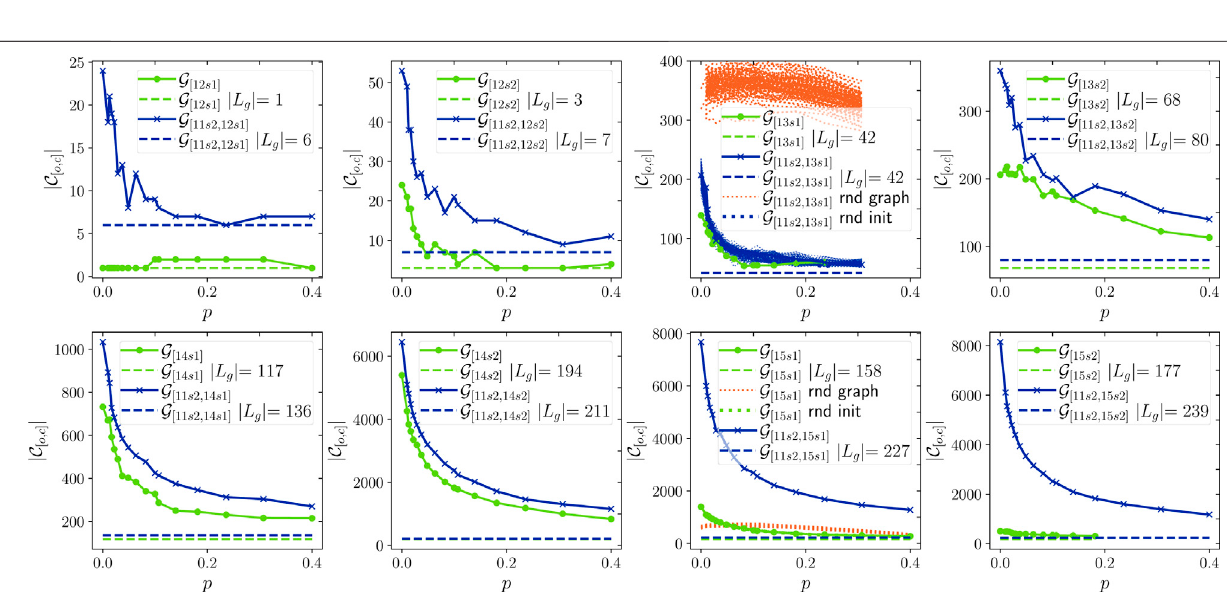
Frontiers in Physics |